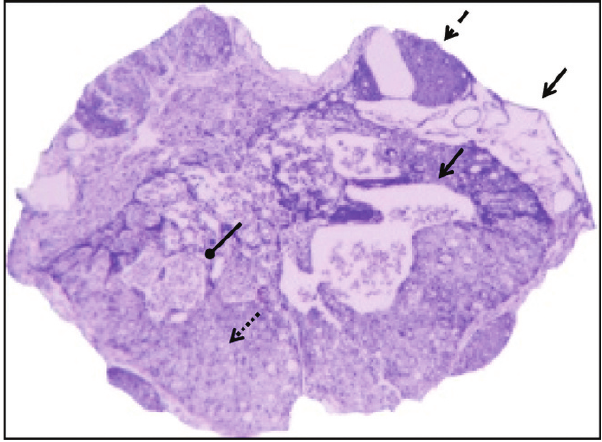
Figure 4 - Injured spinal cord transverse slice, 7 m m thick, with the arrows showing structural/morphological changes after injury, such as spared